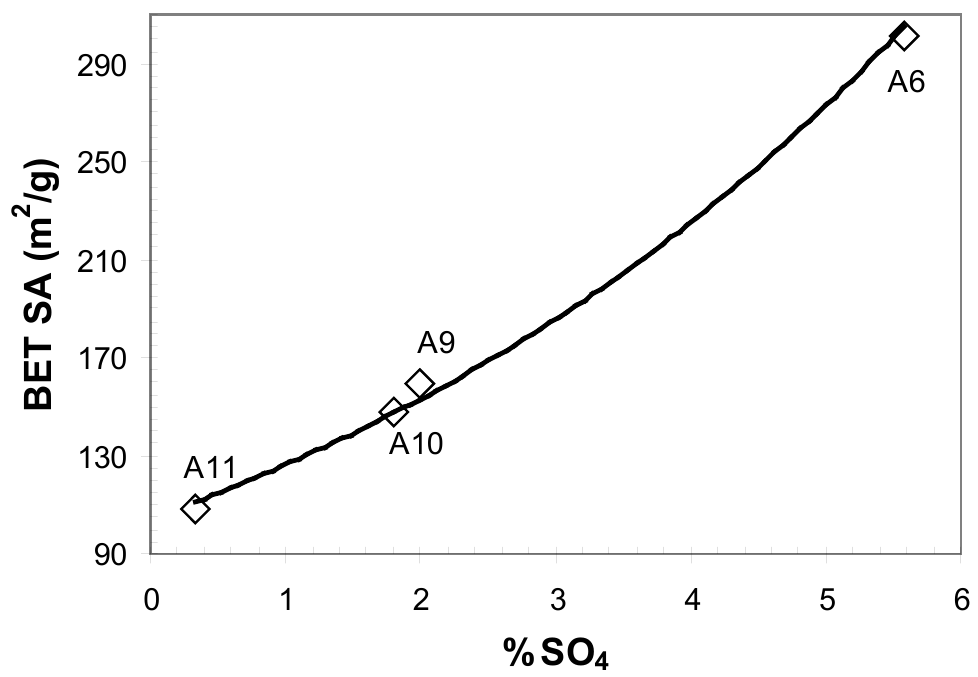
Figure 8. Correlation between sulfate content and surface area for the anatases produced via acid treatment of